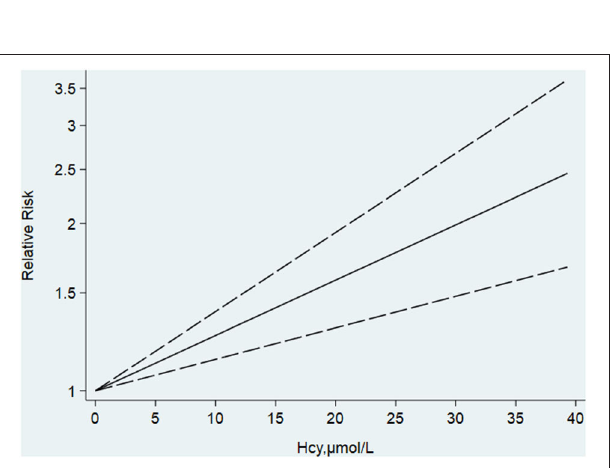
FIGURE 7 | Dose-response analysis of homocysteine and risk of AD. The solid line represents the best fitting cubic spline